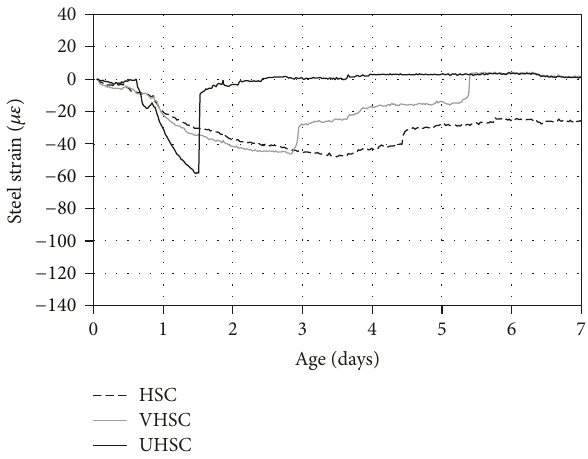
Figure 9: Average strain in the steel ring of HSC, VHSC, and UHSC (35 mm concrete